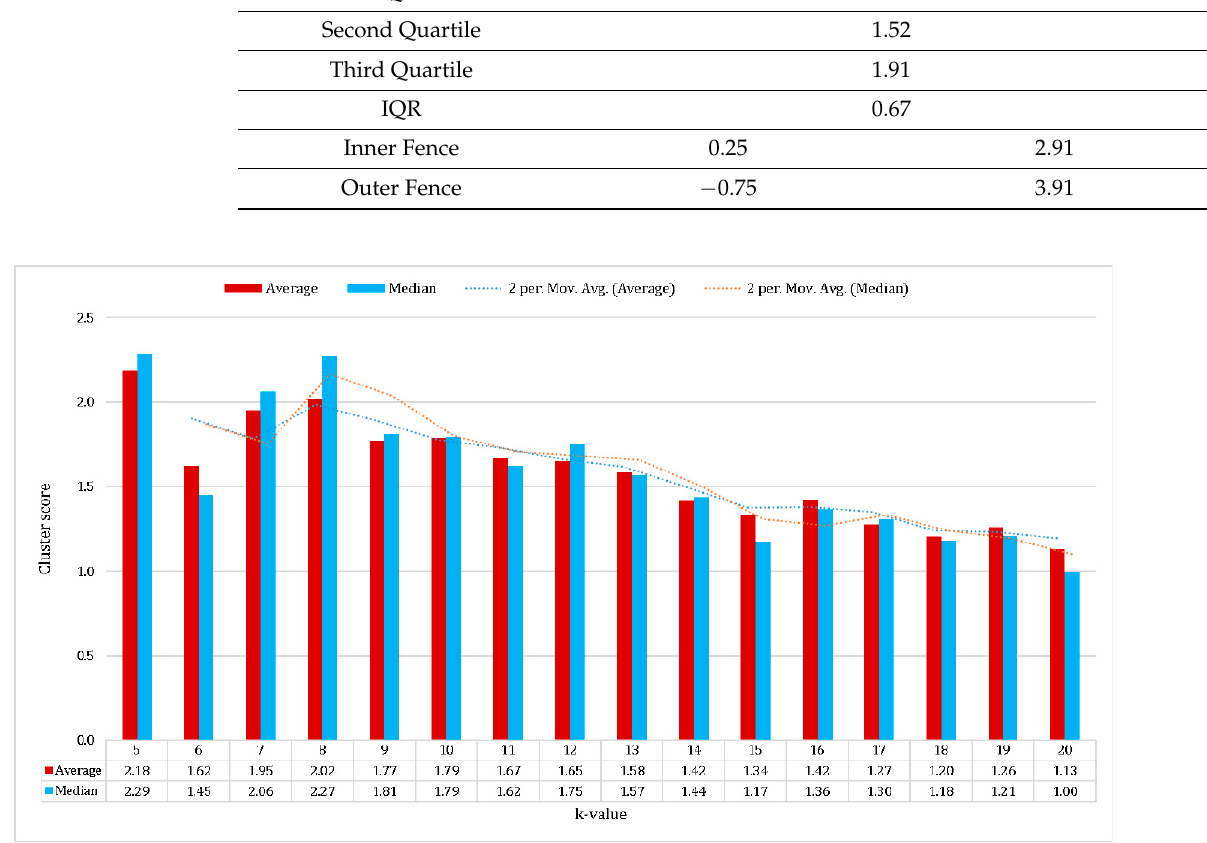
Table 3. Quartiles, inner and outer fence ranges.